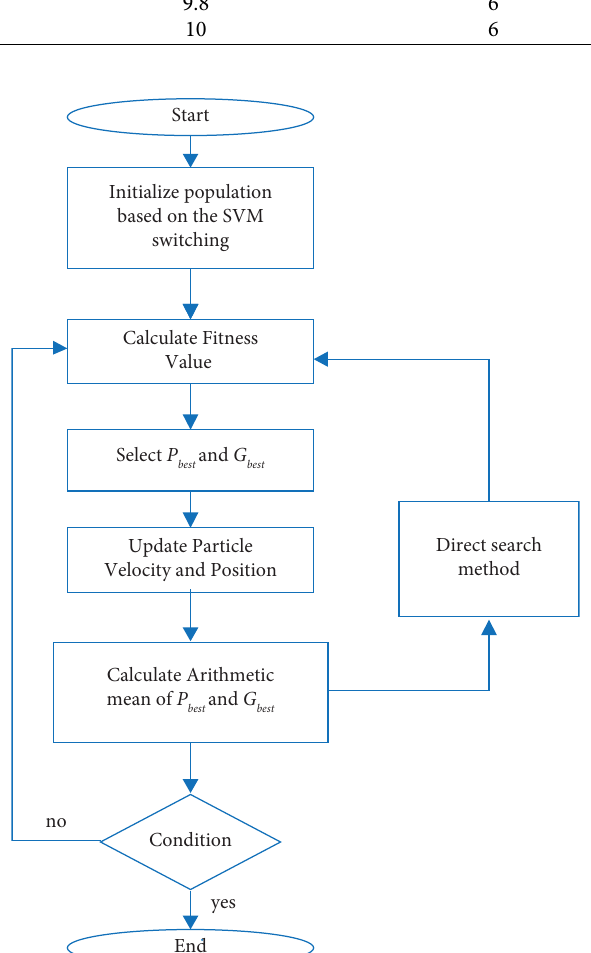
Figure 8: Flowchart of MHPSO